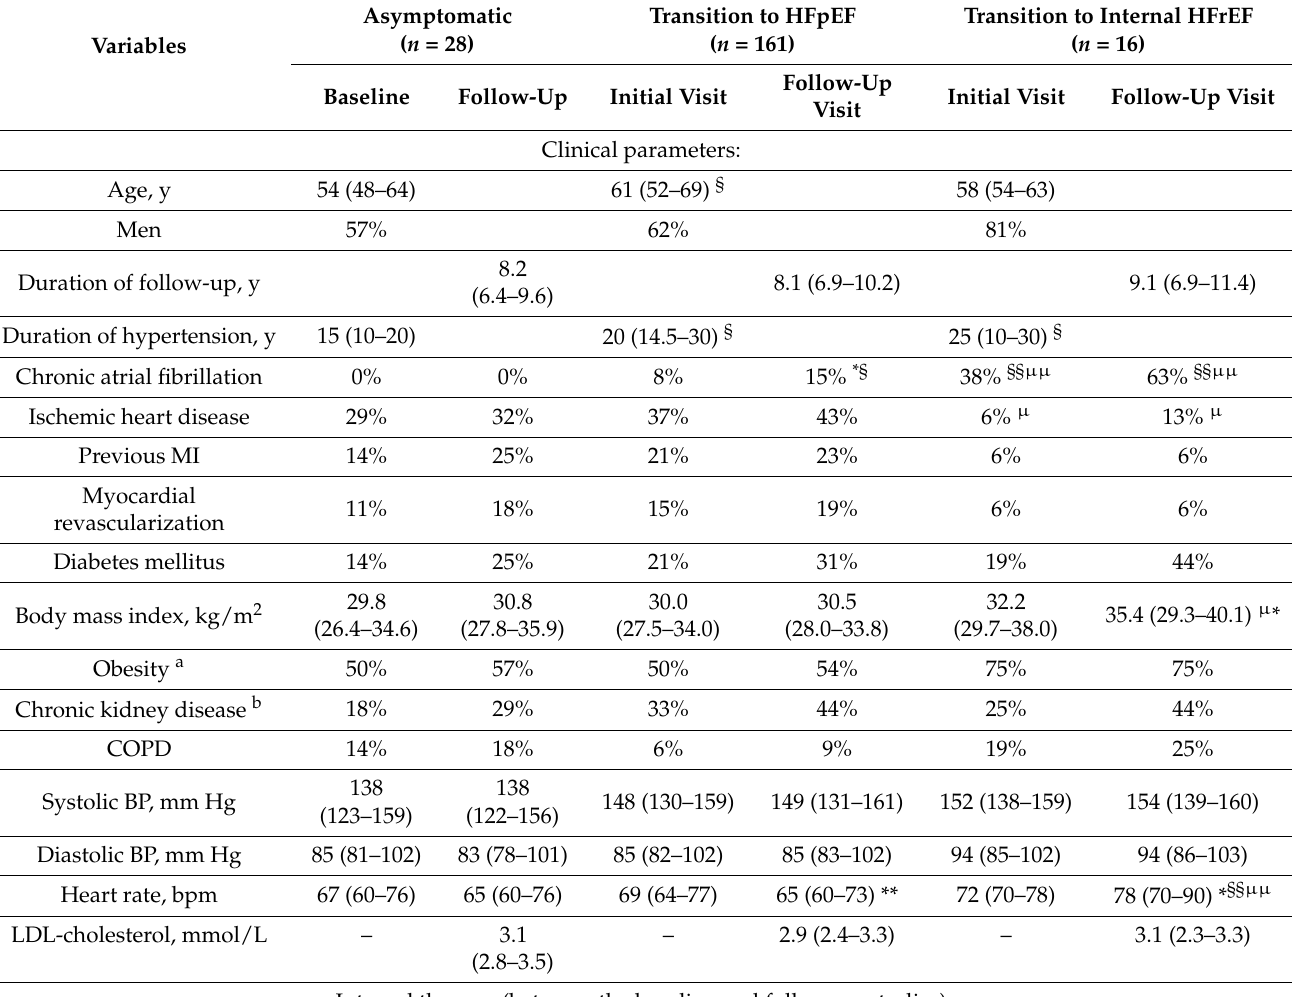
Table 2. Clinical variables and therapy in new-onset HF patients vs. asymptomatic